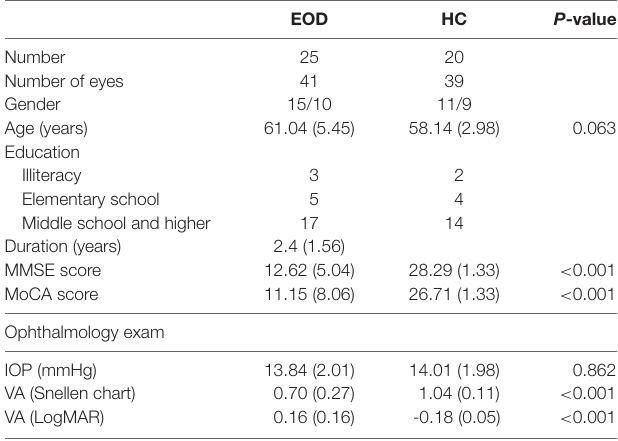
TABLE 1 | Baseline characteristics of the study population.